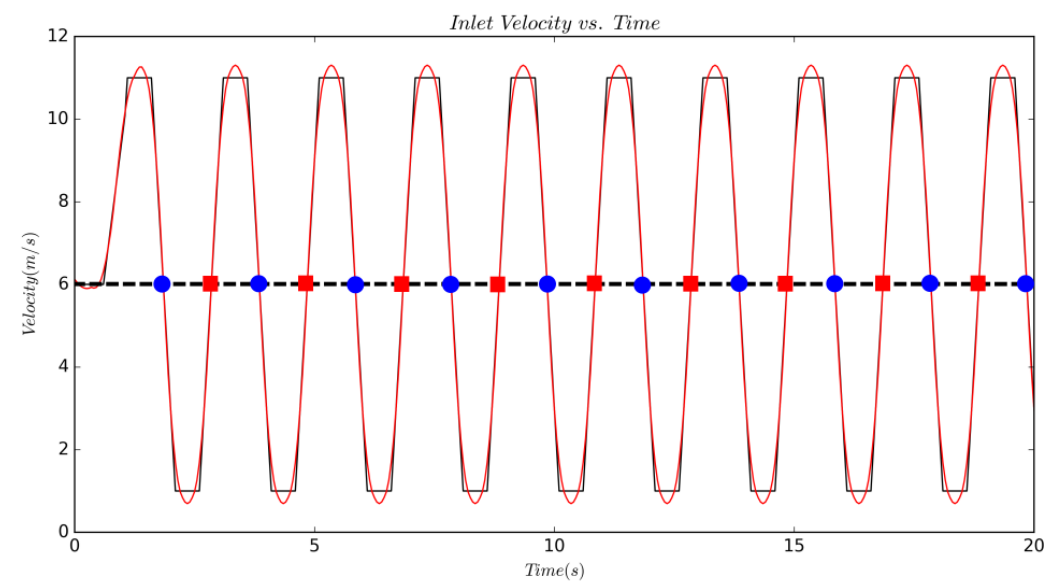
Figure 2. The periodic signal for V inlet ( t ) over 20 s. Black and red lines represent the raw user input signal and smoothed signal, respectively. The blue circles and red squares along the dotted black line indicate instances of recorded deceleration and acceleration events, respectively.